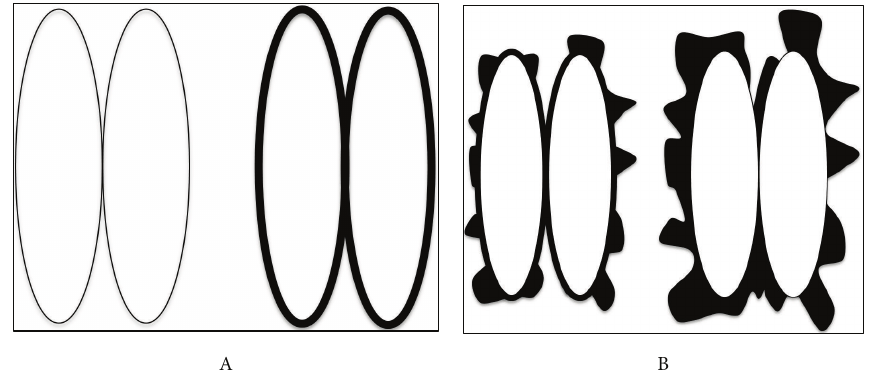
Figure 1: The paired ovals represent axial cross-section through lateral ventricles. Type A—no lesions on axial FLAIR (left) or smooth- bordered periventricular linear hyperintensity (right). No outpouching allowed. Type B—distinct “outpouching” periventricular lesions (left) or diffuse confluent, jagged-border hyperintensity (right).